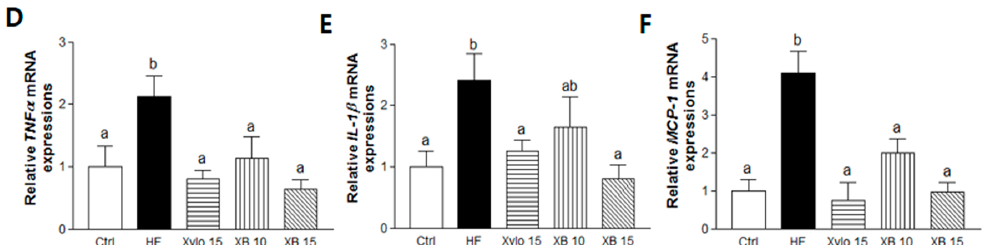
Figure 3. Effects of XB on the expressions of genes related to fatty acid uptake, lipolysis, and pro-inflammatory cytokines in mesenteric adipose tissues. Real-time PCR was performed to detect mRNA level of fatty acid uptake and lipolysis-related genes in mesenteric adipose tissues. ( A ) LPL ;